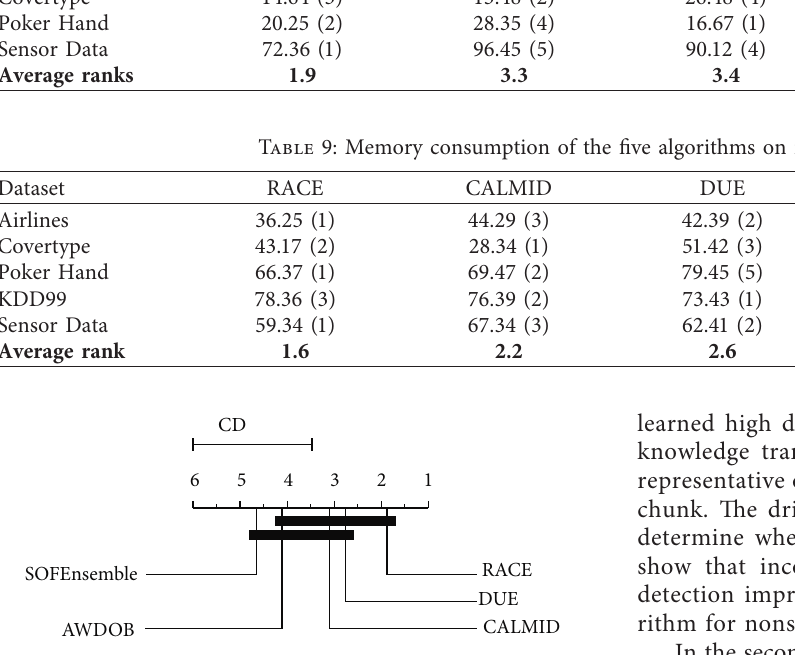
Figure 12: Average rank diagram of compared